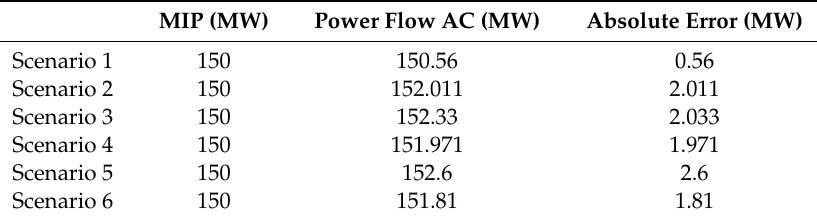
Figure 9. Power generation, first year planning. Table 13. The power generated in node slack, first year